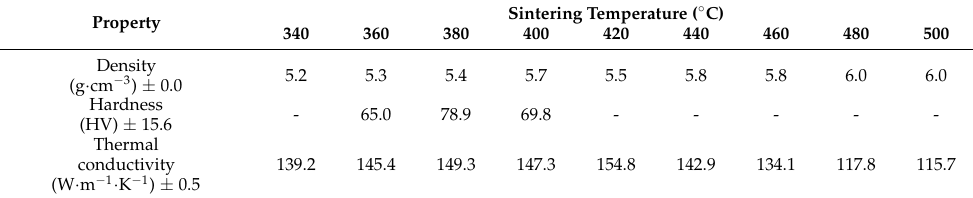
Table 2. Density, Vickers hardness and thermal conductivity of Al–Cu composites.